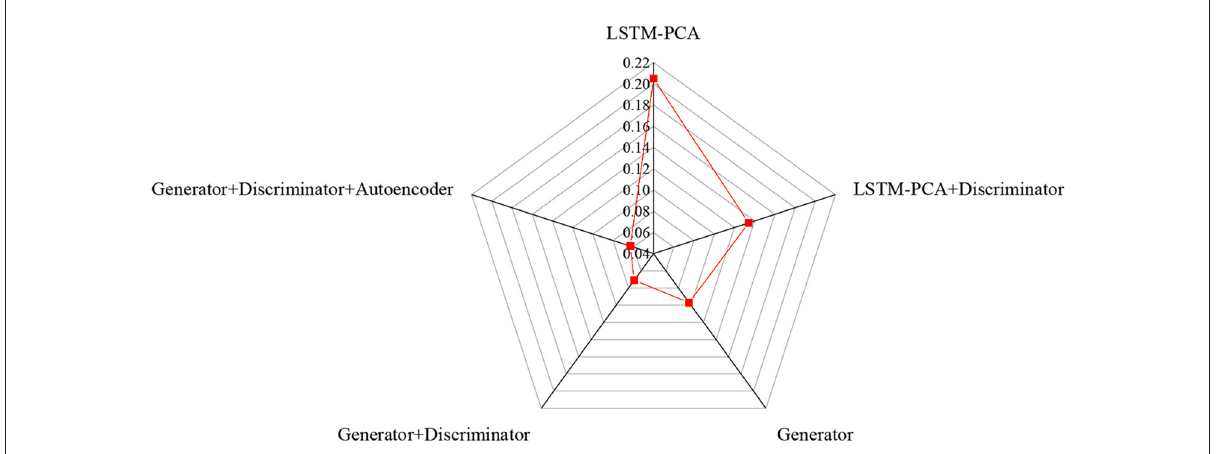
FIGURE9 Similarity between robot-generated dance and real human dance.